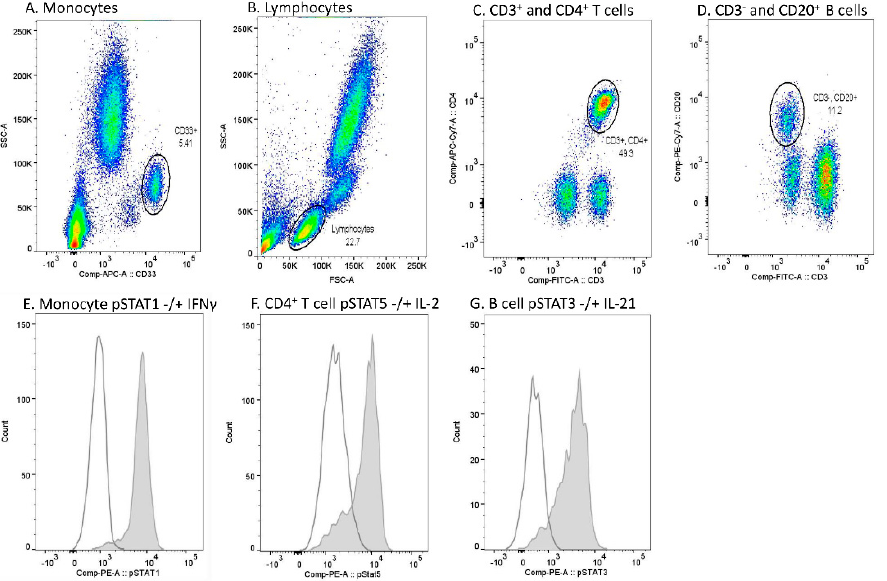
Figure 5. Flow cytometry gating strategy and examples of cytokine-induced phosphorylated STAT (pSTAT) in each cell population in one sample. ( A ) Monocyte gate was set based on CD33 positivity and light scattering characteristics (SSC-A). ( B ) Lymphocytes were gated based on light scattering characteristics (FSC-A and SSC-A). ( C ) Among lymphocytes, the CD4 + T cell gate was set to comprise CD3 + and CD4 + populations. ( D ) Among lymphocytes, the B cell gate was set to comprise CD3 − and CD20 + populations. ( E ) pSTAT1 histograms in unstimulated (open peak) and IFN- γ -stimulated (grey peak) monocytes. ( F ) pSTAT5 histograms in unstimulated (open peak) and IL-2-stimulated (grey peak) CD4 + T cells. ( G ) pSTAT3 histograms in unstimulated (open peak) and IL-21-stimulated (grey peak) B cells.